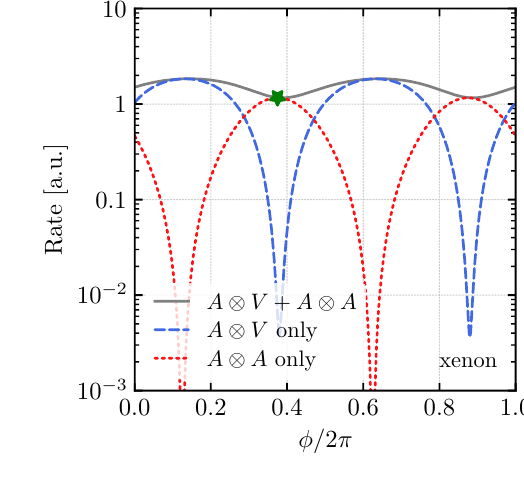
(a) The dotted, dashed, and dash-dotted curves correspond to gauge-anomaly-free scenarios S1, S2 and S3, respectively. The thick horizontal lines correspond to the isospin limit.